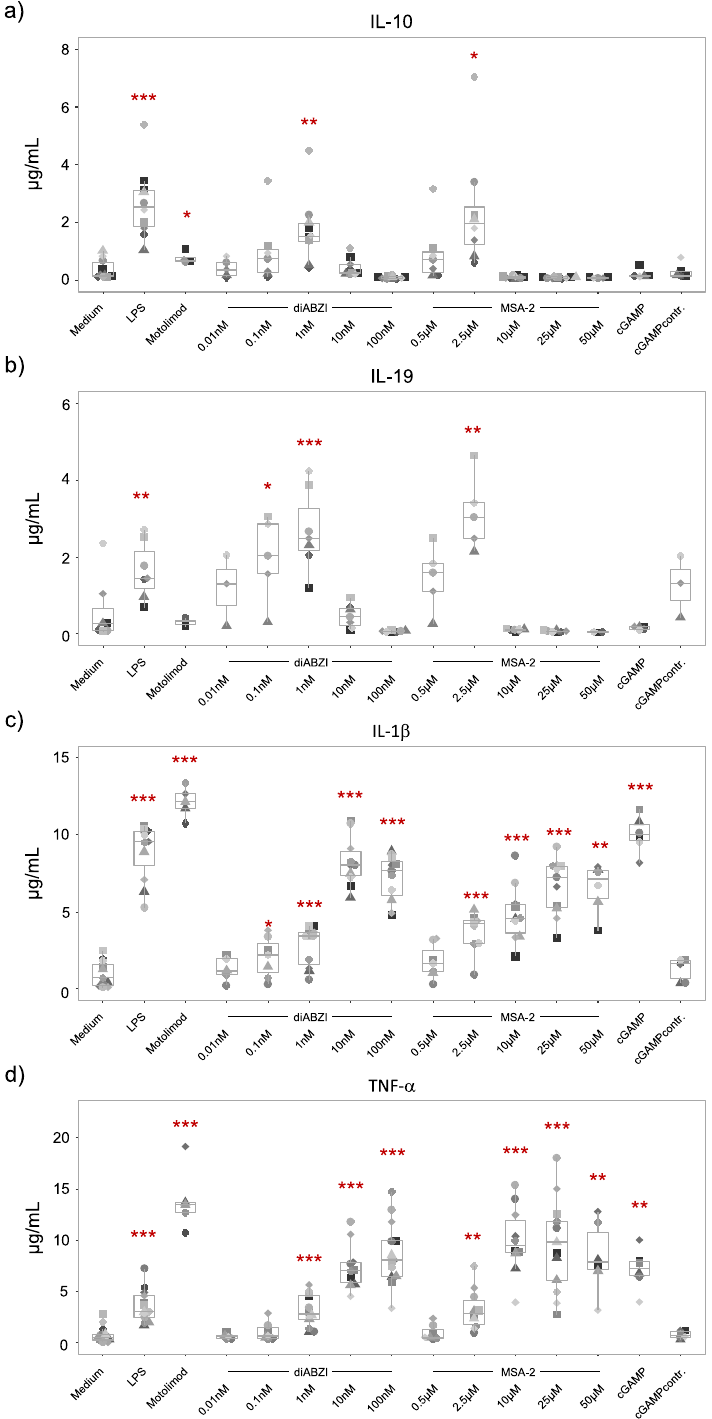
Figure 3. Biphasic pattern of cytokine induction in monocytes. Purified monocytes were cultured in medium only or were stimulated with 100 ng/mL LPS, 0.5 µg/mL Motolimod, 0.01–100 nM diABZI, 0.5–50 µM MSA-2, or 15 µM cGAMP/cGAMP control as indicated. Cytokines were quantified by ELISA in supernatants after 24 h. Each donor is identified by identical symbol and grey tone. ( a ) IL-10 (n = 4–10). ( b ) IL-19 (n = 3–7). ( c ) IL-1β (n = 5–11). ( d ) TNF-α (n = 5–13). Statistical significance was calculated for each group by comparing stimulatory conditions with medium using paired Student’s test. Red asterisks indicate the level of significance between stimulated and unstimulated (medium) samples. *p < 0.05, **p < 0.01, ***p <